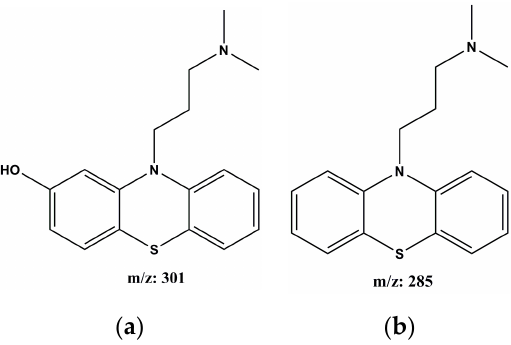
Figure 8. Possible structures of the two most stable products under anaerobic conditions.